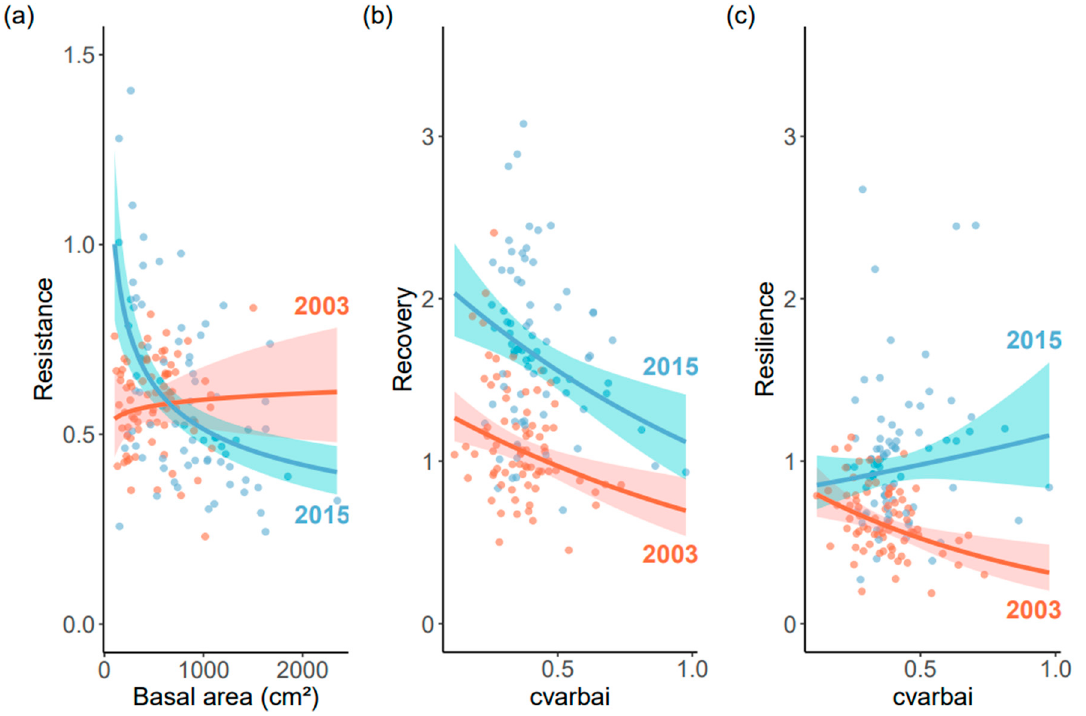
Figure 6. Predictions for resistance ( a ), recovery ( b ), and resilience ( c ) for the 2003 and 2015 drought events based on the best models. The blue, respectively the red, zone around the predicted course indicates the 95% confidence interval. Note the different scale for resistance. For resistance and re- silience, the predictor strudiv (structural diversity), included in the best model, was set to mean, while other variables were predicted independently. Effects of different levels of structural diversity are not presented here since this predictor was not significant in the models ( p > 0.05). Table 3. Parameter estimates and standard errors ( se ) of the best models for resistance (left), recov- ery (center), and resilience (right) resulting from the multi-model inference. α are the regression coefficients of the fixed covariates, b represents the random intercept, ε is the error term, and N stands for the number of trees, respectively the number of observations. Significance levels: *** = 0.001, ** = 0.01, * = 0.05, ° = 0.1. Resistance